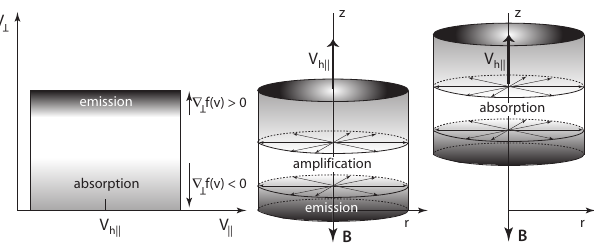
Fig. 7. Electron-cyclotron maser radiation generated and trapped in an idealised cylindrical hole moving with speed v h k along the mag- netic field from strong to weak magnetic field strengths B . Left: the hole in velocity space, v k ,v ⊥ , showing the regions of velocity space gradients where emission and absorption is expected to take place. Right: real space trapping of radiation inside the hole. Radiation trapping (indicated by two-sided arrows in radial perpendicular di- rection, i.e. the direction of wave propagation) takes place in radial direction, r , at any azimuthal angle perpendicular to B . The trapped wave is emitted at resonant frequency ω with narrow bandwidth 1ω . Shown is radiation emitted at the high-frequency end of the hole in the strong magnetic field where the radiation is in resonance and is amplified. When the hole moves up to lower fields (shown on right), radiation at given frequency ω enters the absorption band and experiences damping. Radiation will be released in X mode at residual intensity when the hole resolves and passes beyond the X- mode cut-off (see Fig. 8). When the hole resolves before passing the cut-off, radiation will be in the Z